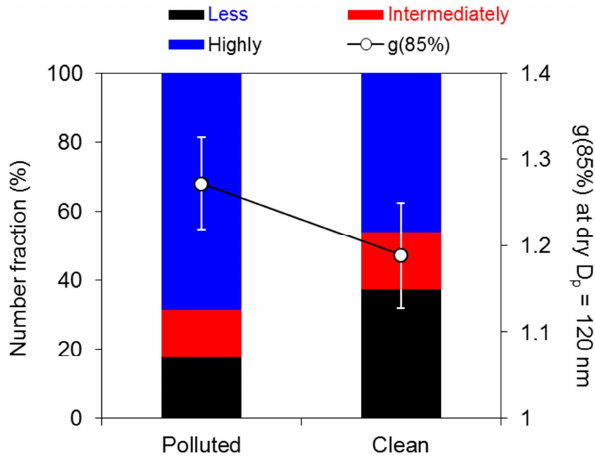
Figure 8. Average number fractions of less-, intermediately, and highly hygroscopic particles at dry D p values of 120nm during the polluted and clean periods. Average g (85%) values of particles are also shown. Error bar represents 1 σ of g (85%)